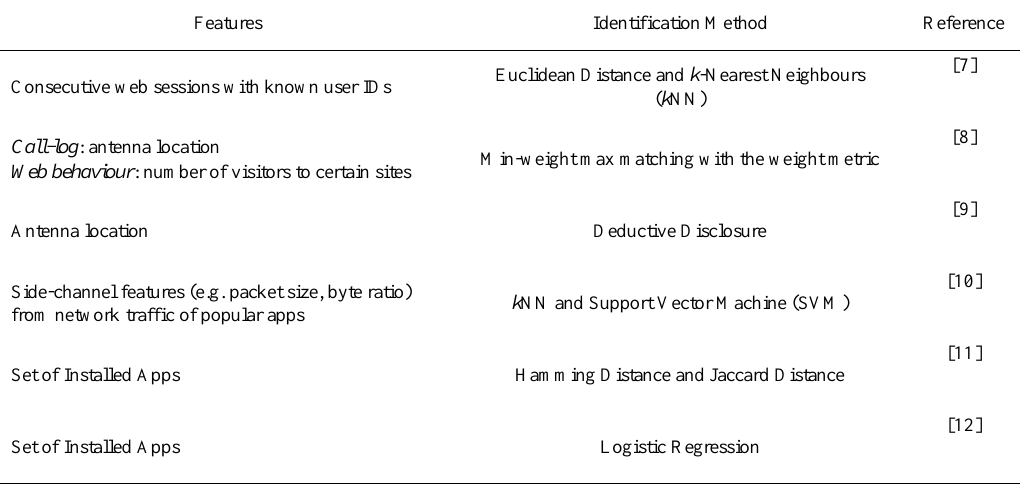
Table 2. User identification using smartphone usage